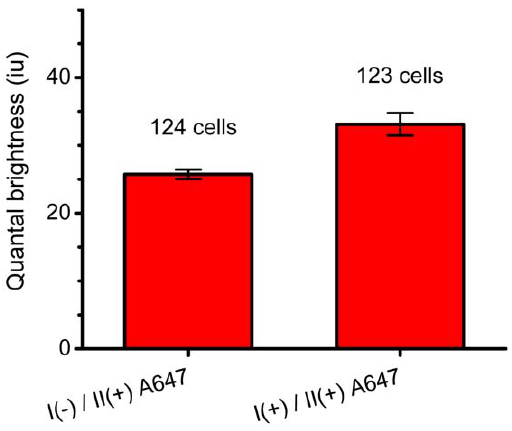
Figure 11. Non specific binding control of the antibody used for kidney tissue staining. HEK293 cells were transiently transfected with NBCe1-A-EGFP mutant. Post fixation, cells were immunolabeled with both primary anti-wt-NBCe1-A antibody (I) and secondary Alexa Fluor 647 conjugated antibody (II) (right bar), and with secondary Alexa Fluor 647 conjugated antibody alone (left bar). The moment analysis reveals non-significant binding of both primary and secondary antibody together. The secondary antibody was identical to the one used for tissue immunostaining except it was labeled with Alexa 647.